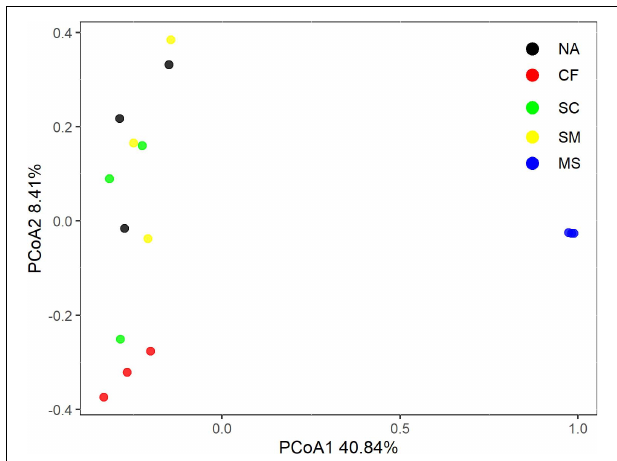
FIGURE 3 | The structure of soil autotrophic bacterial community by principal coordinate analysis (PCoA), which is constrained by five treatments based on Bray–Curtis distances. NA, no amendment; CF, chemical fertilizer; SC, 50% chemical N fertilizer plus 50% organic N fertilizer; SM, organic fertilizer; MS, maize